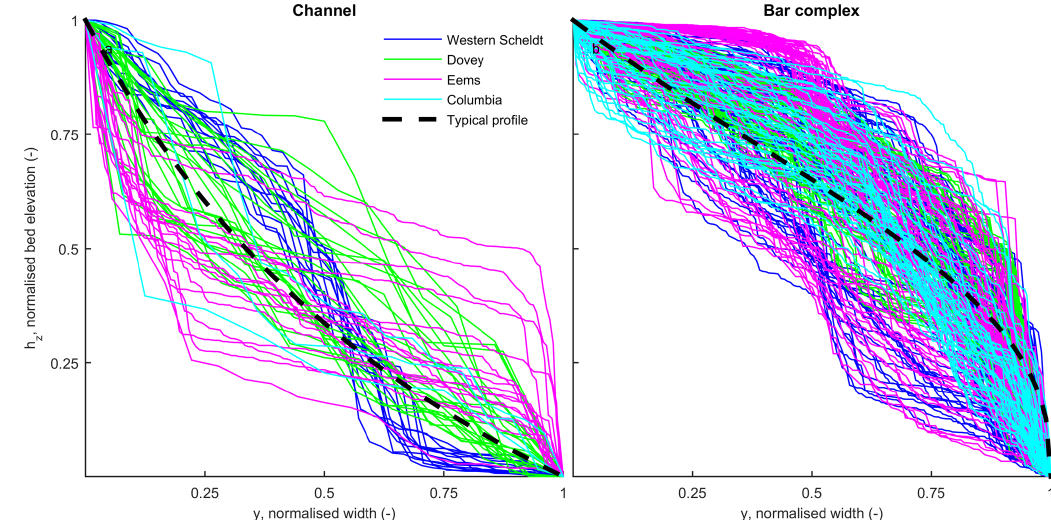
Figure 5. Hypsometric curves as extracted from bathymetry in the Western Scheldt, Dovey, Eems and Columbia River. Cross-sectional profiles were extracted along the centreline (Sect. 2.3) and were subsequently classified as channel when sand bars were (mostly) absent and as bar complex when one larger bar dissected by barb channels or multiple smaller bars was present. Channel-dominated morphology generally results in concave hypsometric profiles (a) and bar complexes in convex profiles (b)